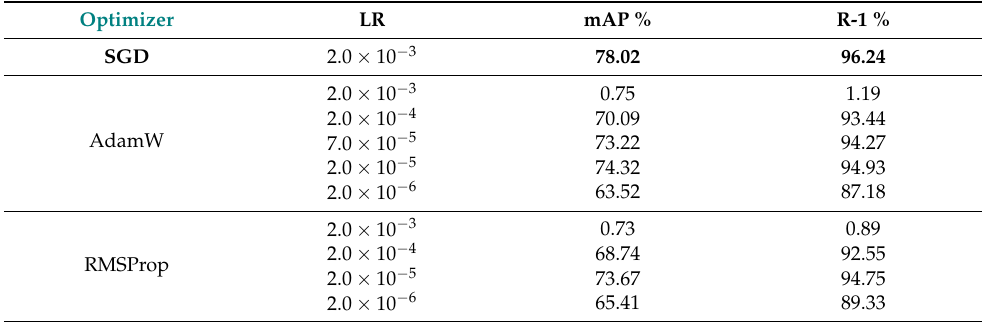
Table 11. Performance of the models using the three losses, without the BNNeck and different optimizers and learning rates.